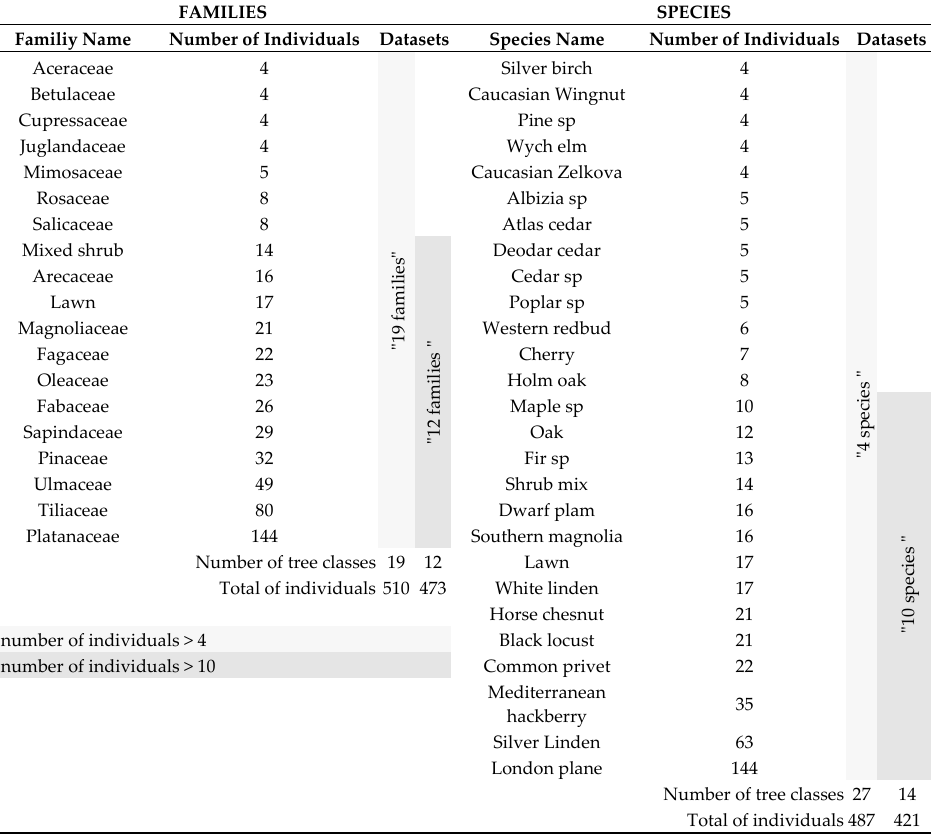
Table 3. Trainingdatasetsaccordingtofamiliesandspeciesnomenclatureoftreesandtheirrepresentativeness (number of individuals surveyed during the fieldwork). Remote Sens. 2019 , 11 , x FOR PEER REVIEW